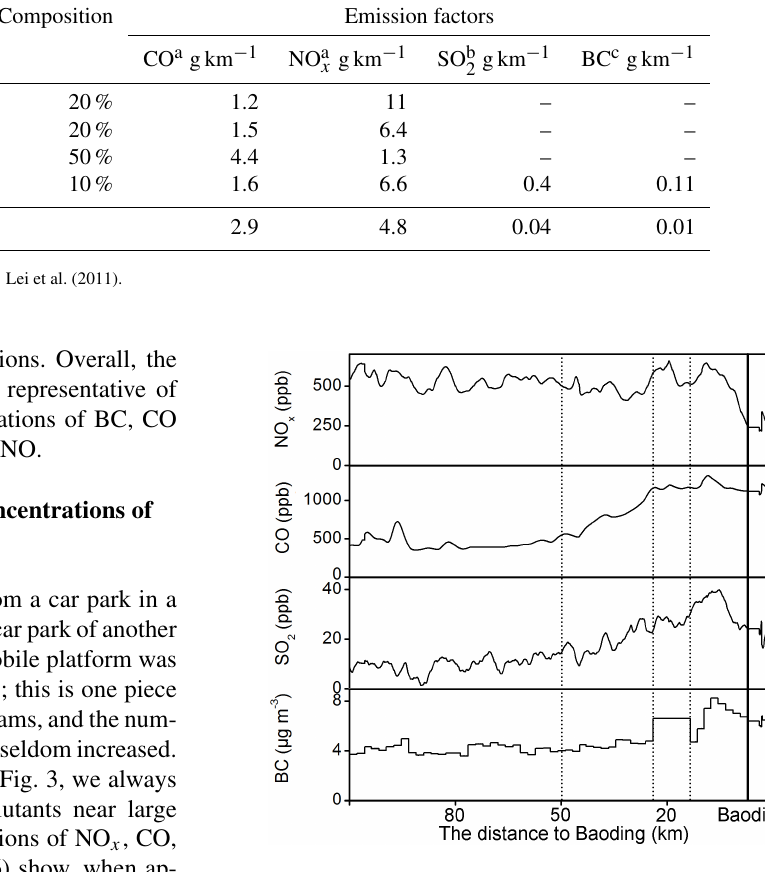
Figure 6. The time series of the concentrations of NO x , CO, SO 2 and BC measured on 13 June (the three dashed lines mark 50, 23 and 15km to Baoding, and the solid line marks the location of Baod-